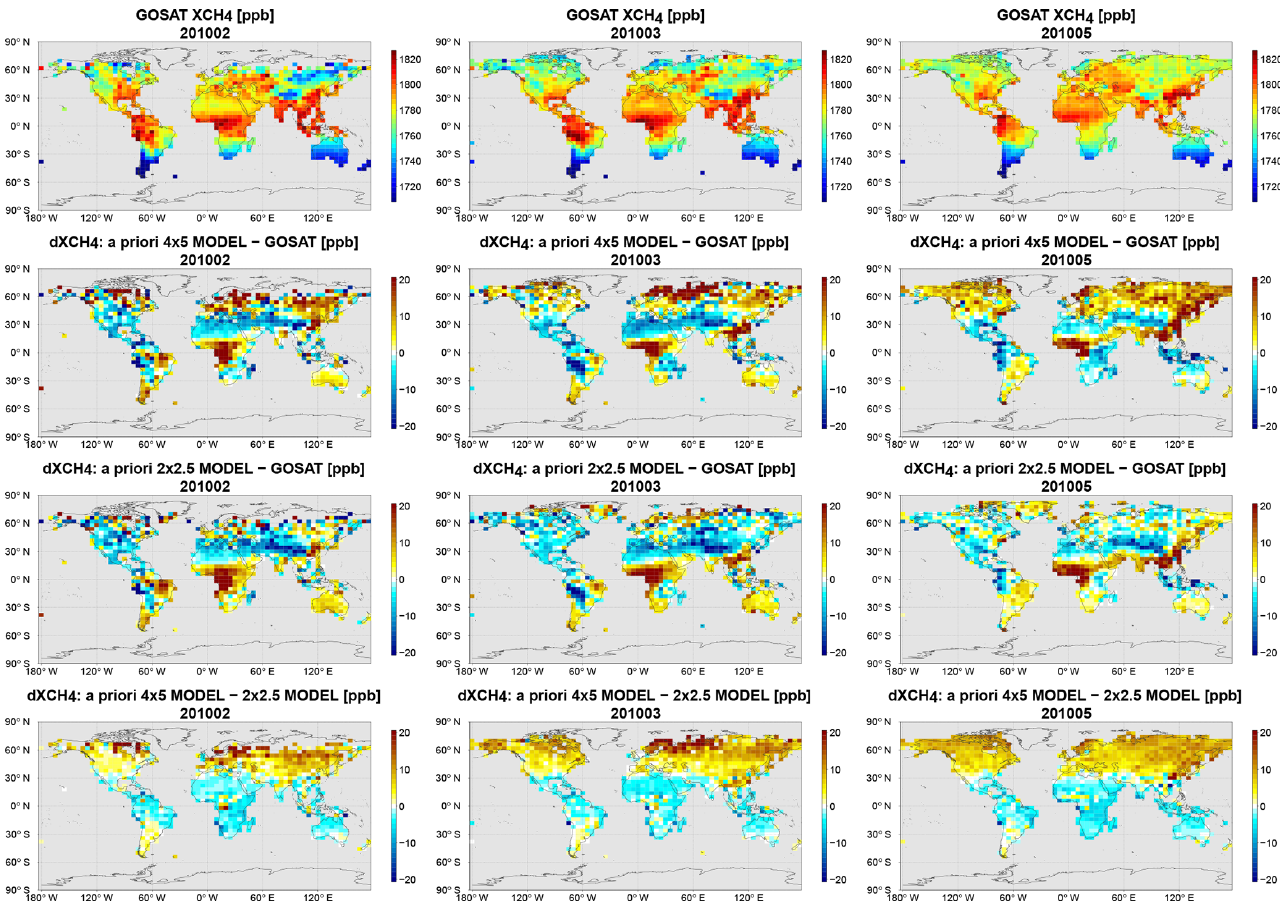
Figure 1. Monthly mean fields for February, March, and May 2010 (columns 1–3). First row: GOSAT XCH 4 retrievals based on the new XCO 2 proxy fields. Second row: a priori XCH 4 difference between the 4 ◦ × 5 ◦ GEOS-Chem and GOSAT. Third row: a priori XCH 4 difference between the 2 ◦ × 2 . 5 ◦ GEOS-Chem and GOSAT averaged to the 4 ◦ × 5 ◦ resolution. Fourth row: XCH 4 bias calculated as the difference between the GEOS-Chem 4 ◦ × 5 ◦ and 2 ◦ × 2 . 5 ◦ fields co-located with GOSAT observations and smoothed with the GOSAT averaging